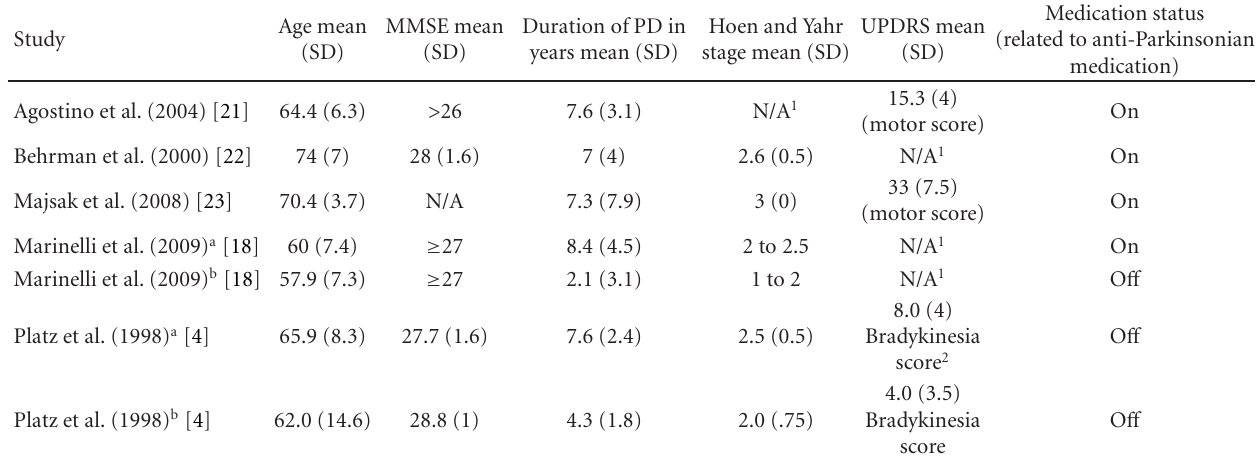
Table 2: Descriptive statistics of participants with PD in the included